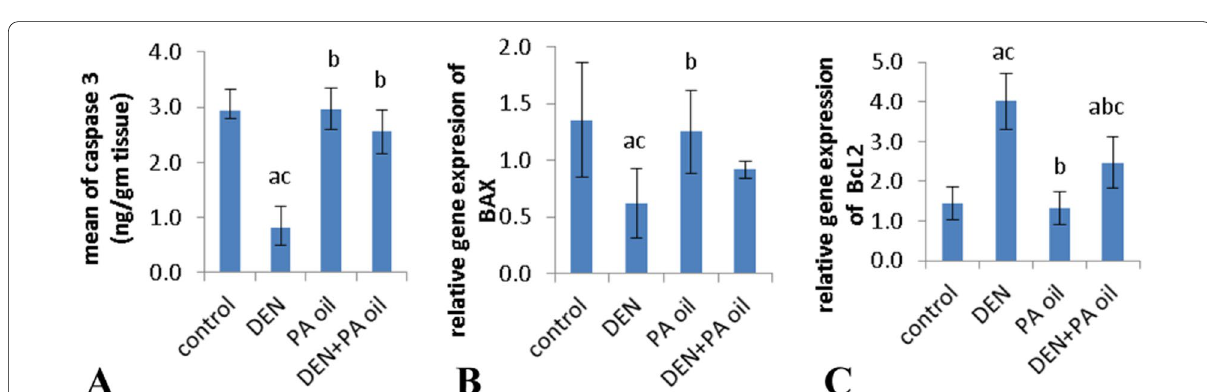
Fig.2 A–C Effect of PA oil on caspase levels in liver tissue and relative gene expression of BAX and BcL2 in rats subjected to induced hepatotoxicity. The values are expressed as mean c Significant to PA oil group ( P =